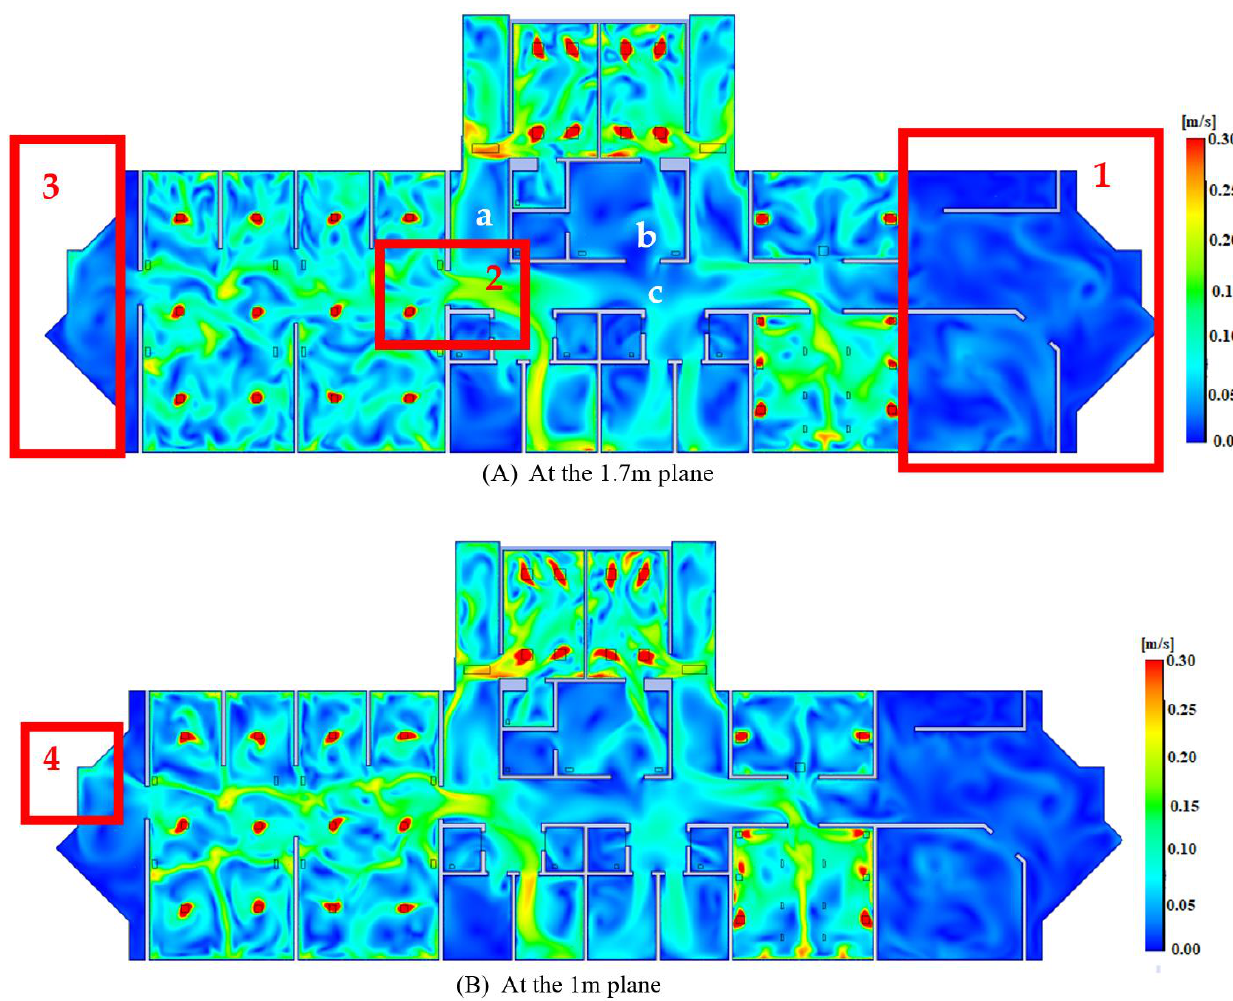
Figure 6. Velocity Figure 6. Velocity profiles.